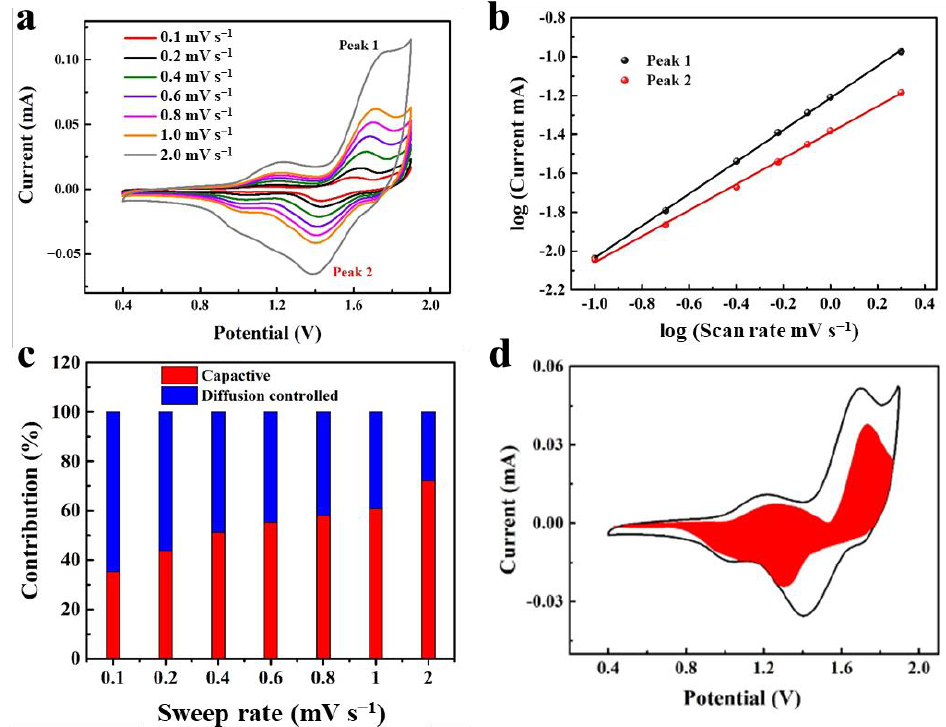
Figure 4. ( a ) CV curves at different scan rates; ( b ) logarithmic relationship between peak current and scan rate; ( c ) the diffusion and capacitance contributions at different a scan rates; ( d ) the contribution proportion of pseudocapacitance at 0.8 mV s −1 .